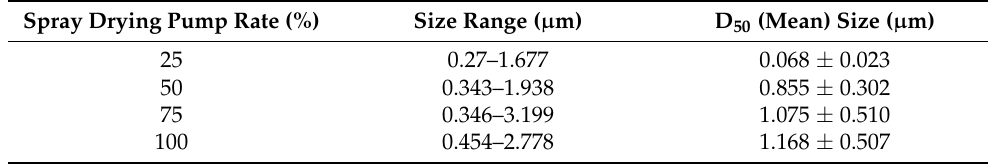
Table 2. Particle sizing using image analysis on SEM micrographs ( n ≥ 100 particles). Spray Drying Pump Rate